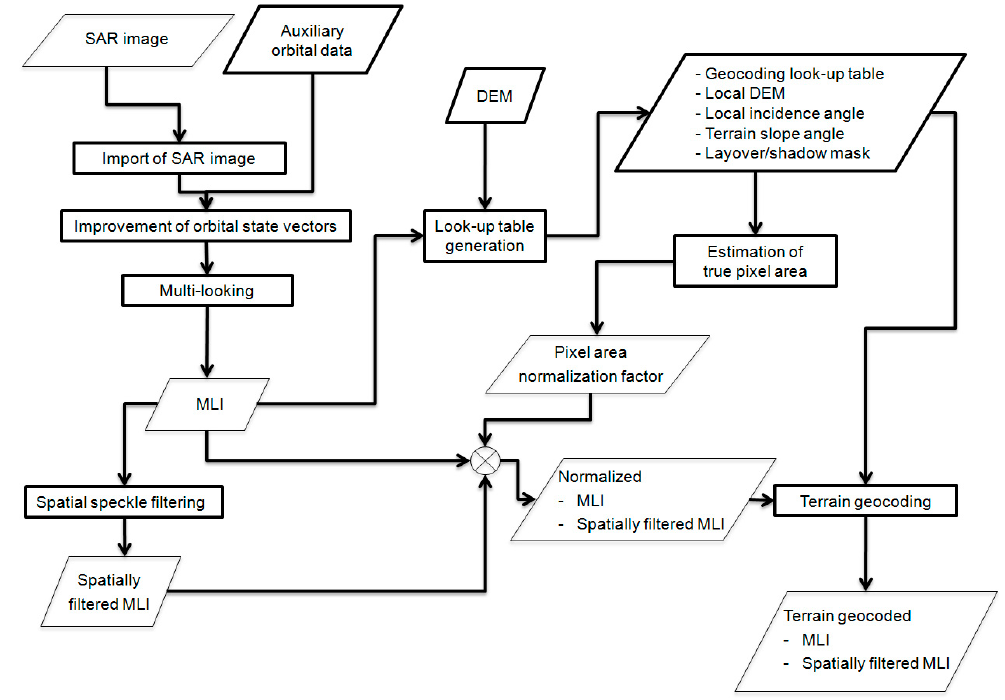
Figure 2. Flowchart of processing for a SAR image. DEM: Digital Elevation Model. MLI: Multi-looked Intensity.